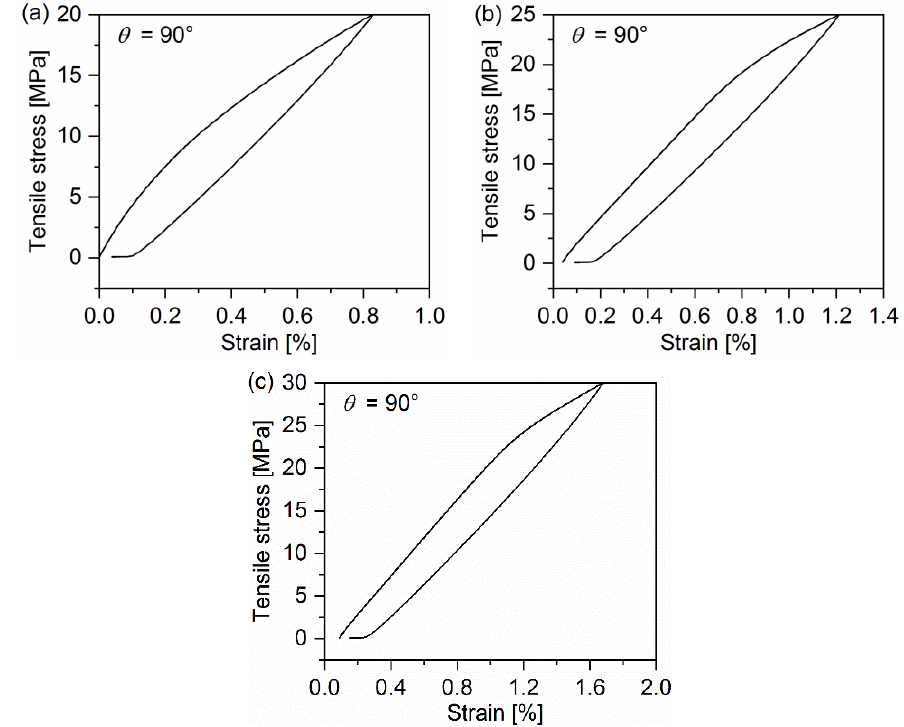
Figure 4. Representative curves from multilevel cyclic loading-unloading recovery tests for the 90° off-axis sample: ( a ) Peak stress: 20 MPa, ( b ) peak stress: 25 MPa and ( c ) peak stress: 30 MPa.